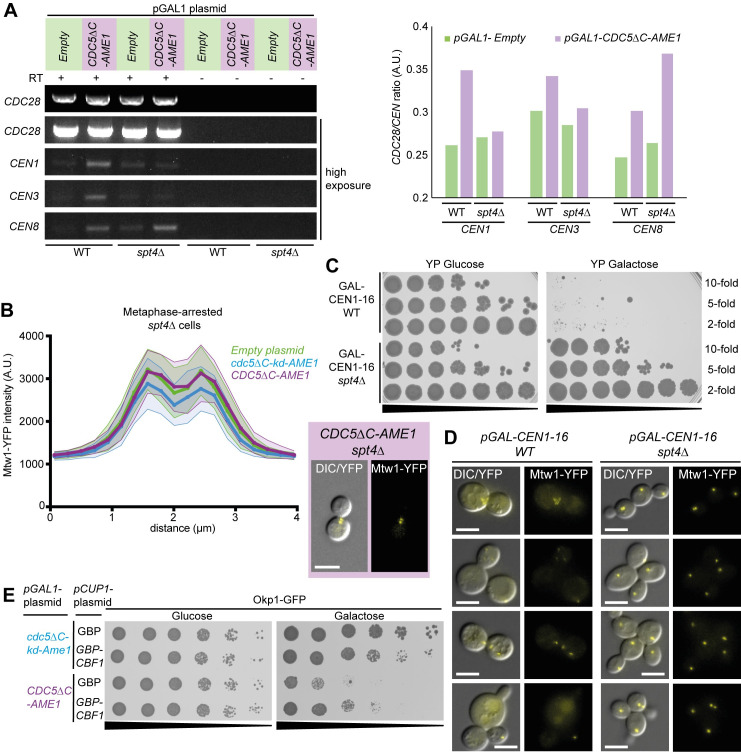
Association of Cdc5 with Ame1 increases centromeric RNA levels which largely depends on Spt4.(A) Reverse transcription PCR (RT-PCR) was performed after five hours of induction of CDC5ΔC-AME1 in wild-type and spt4Δ cells. Reactions without reverse transcription were used to control for potential contaminating DNA. Due to very faint CEN signal the exposure was increased to visualize the CEN RNA bands (see Materials and methods for further details). Quantification of the relative CEN RNA levels is shown in the graph on the right. Ratio of the CDC28 RNA control to the CEN RNAs was calculated. (B) Live imaging of metaphase-arrested Mtw1-YFP cells expressing CDC5ΔC-AME1 or controls and the kinetochore foci analysis was performed as in Fig 4 but in a spt4Δ strain (T739). The scattered Mtw1-YFP foci phenotype seen in Fig 4A was absent in spt4Δ cells (represented in the inset on the right). (C) A serial dilutions spot assay (10-, 5- and 2-fold) was performed with a GALCEN1-16 strain in both wild-type (W8164-2B) and spt4Δ background (T682). GALCEN1-16 spt4Δ strain grew equally well on glucose and galactose after two days at 30°C, in contrast to GALCEN1-16 WT which did not grow on galactose. (D) GALCEN1-16 Mtw1-YFP strains in either a WT (T360) or spt4Δ (T738) background were grown in galactose media for 16 hours and then imaged with fluorescence microscopy to investigate the kinetochore phenotype. In WT cells we found a range of phenotypes with cells showing scattered/fractured kinetochores or some with a diffused Mtw1-YFP signal whereas in spt4Δ cells this was not the case. We note that after 4–6 hours in galactose the cells did not show a clear phenotype. All scale bars are 5μm. (E) 5-fold serial dilutions spot assay of Okp1-GFP cells coexpressing CDC5ΔC-AME1 and GBP-CBF1 or GBP shows that additional Cbf1 recruitment partially suppresses the growth defect caused by CDC5ΔC-AME1 expression.